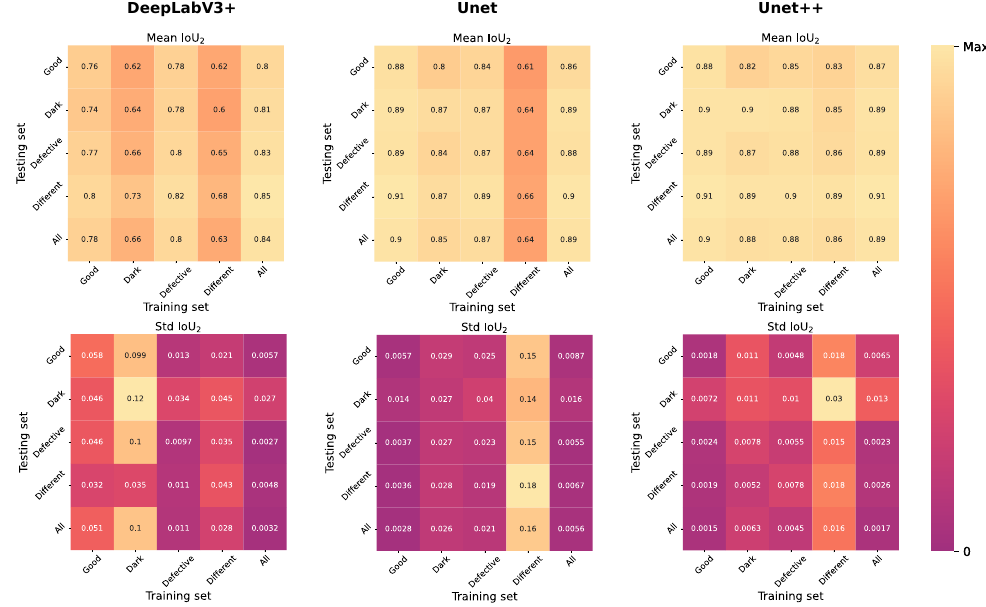
Figure 2. Performanceon test data belonging to different groups based on models trained on different training data. The first row contains the mean values of IoU 3 . The second row contains standard errors of mean IoU 3 . Each column corresponds to one of the selected network architectures—DeepLavV3+, Unet, Unet++.